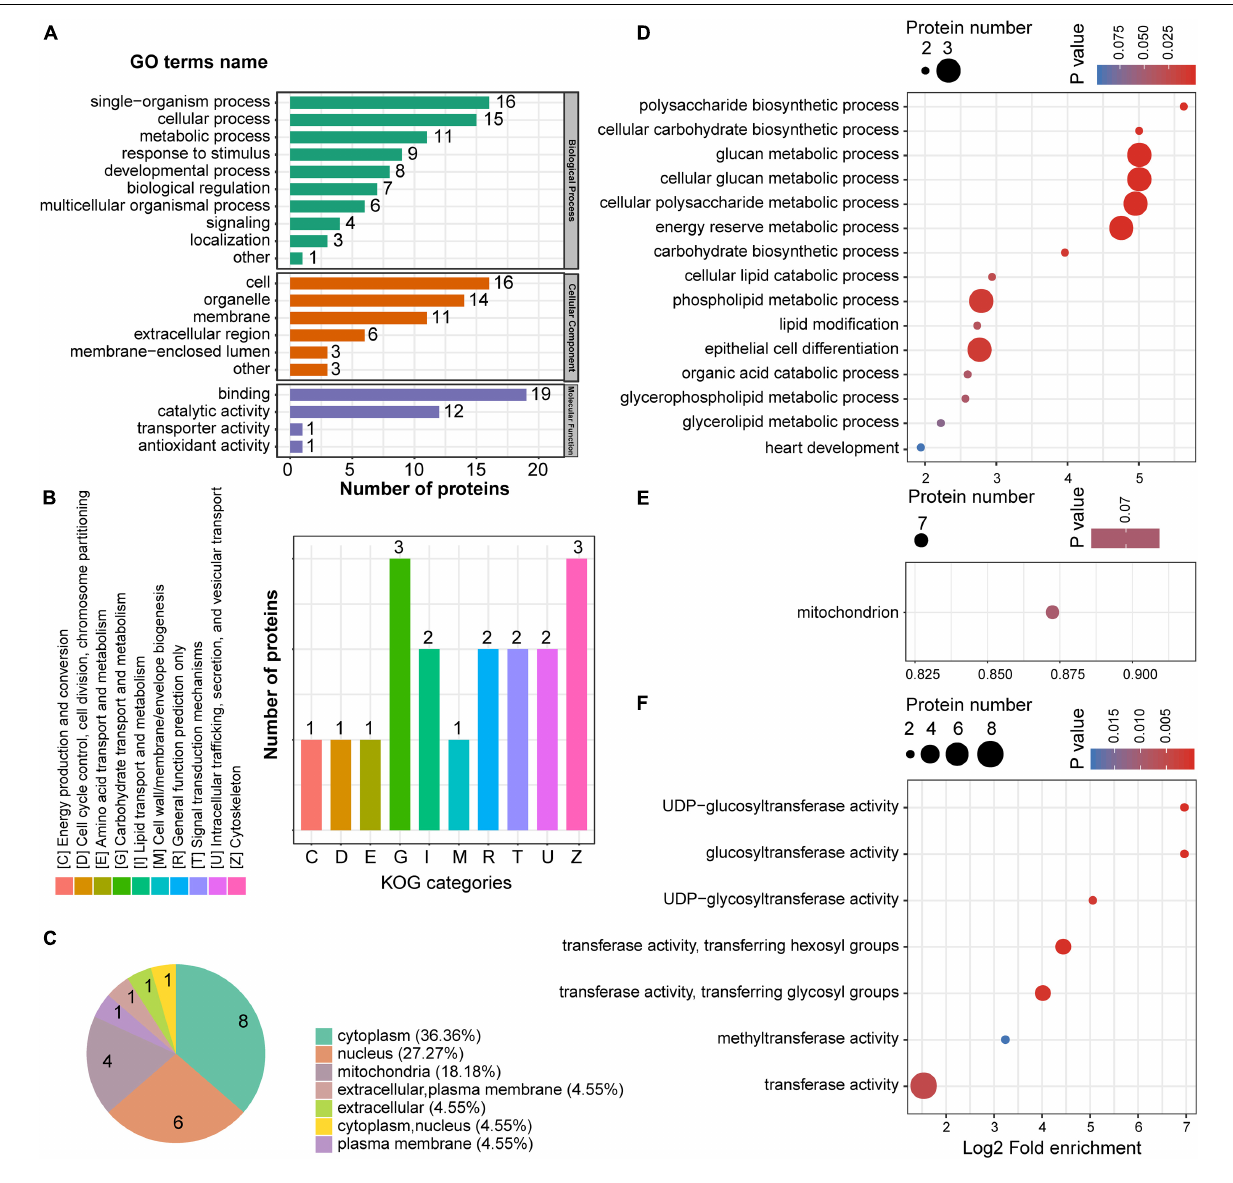
FIGURE 5 | The GO enrichment of down-regulated proteins in the mPFC. (A) GO annotations of downregulated proteins in the mPFC. (B) Cluster of orthologous groups for enkaryotic complete genomes (KOG) classification of downregulated proteins. (C) Subcellular localization analysis of downregulated proteins. (D–F) GO enrichment analysis according to the downregulated proteins in the mPFC. Biological process (D) , cellular compartment (E) , and molecular function (F)